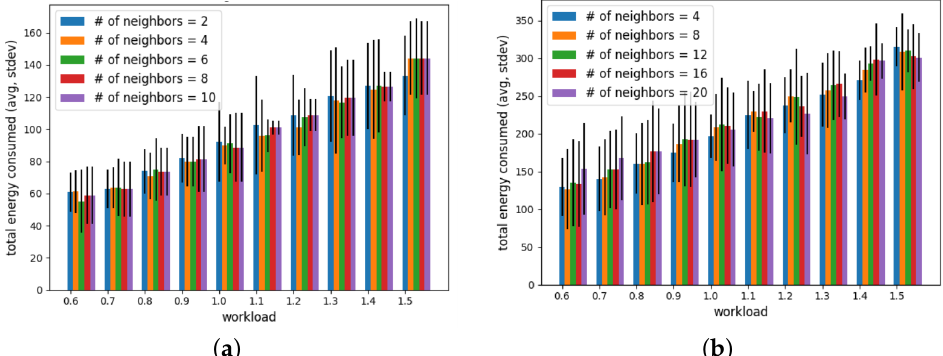
Figure 10. Total energy consumption when the neighborhood range varies and q th = 0.7. ( a ) The number of MECSs is 10; ( b ) The number of MECSs is 20.